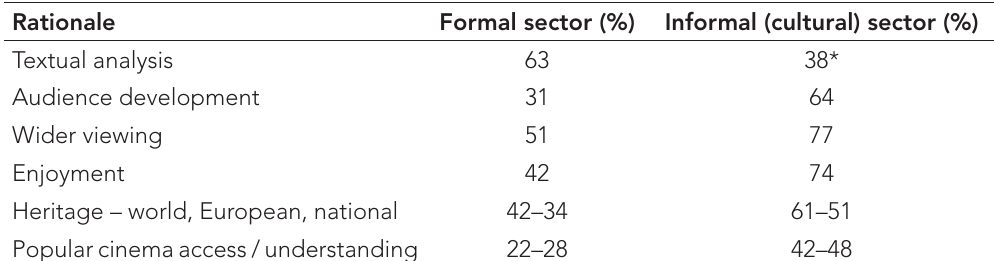
Table 1: Ranking of different rationales for film education in formal and informal settings given by 50 respondents to Screening Literacy (compiled from Reid et al. , 2013) Rationale Formal sector (%) Informal (cultural) sector (%) Textual analysis 63